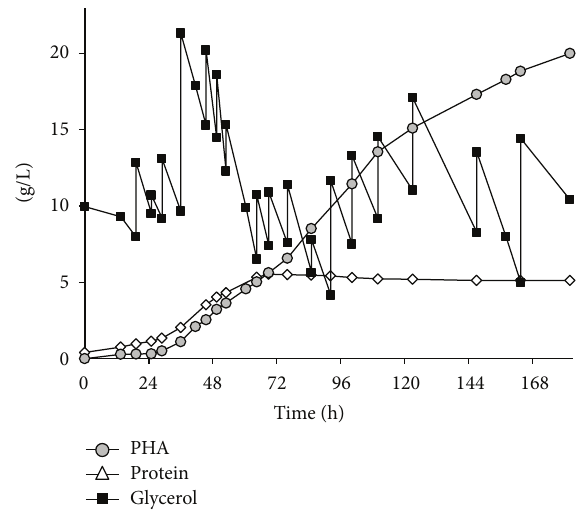
Figure 2: Fermentation pattern for PHA production on CGP: time curves of substrate and